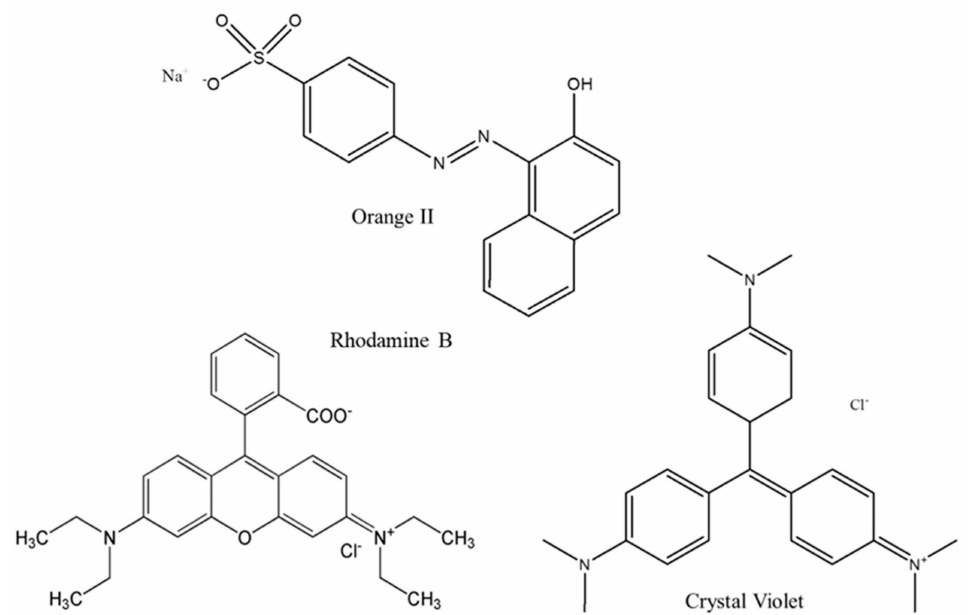
Figure 7. Orange II, rhodamine B and crystal violet chemical